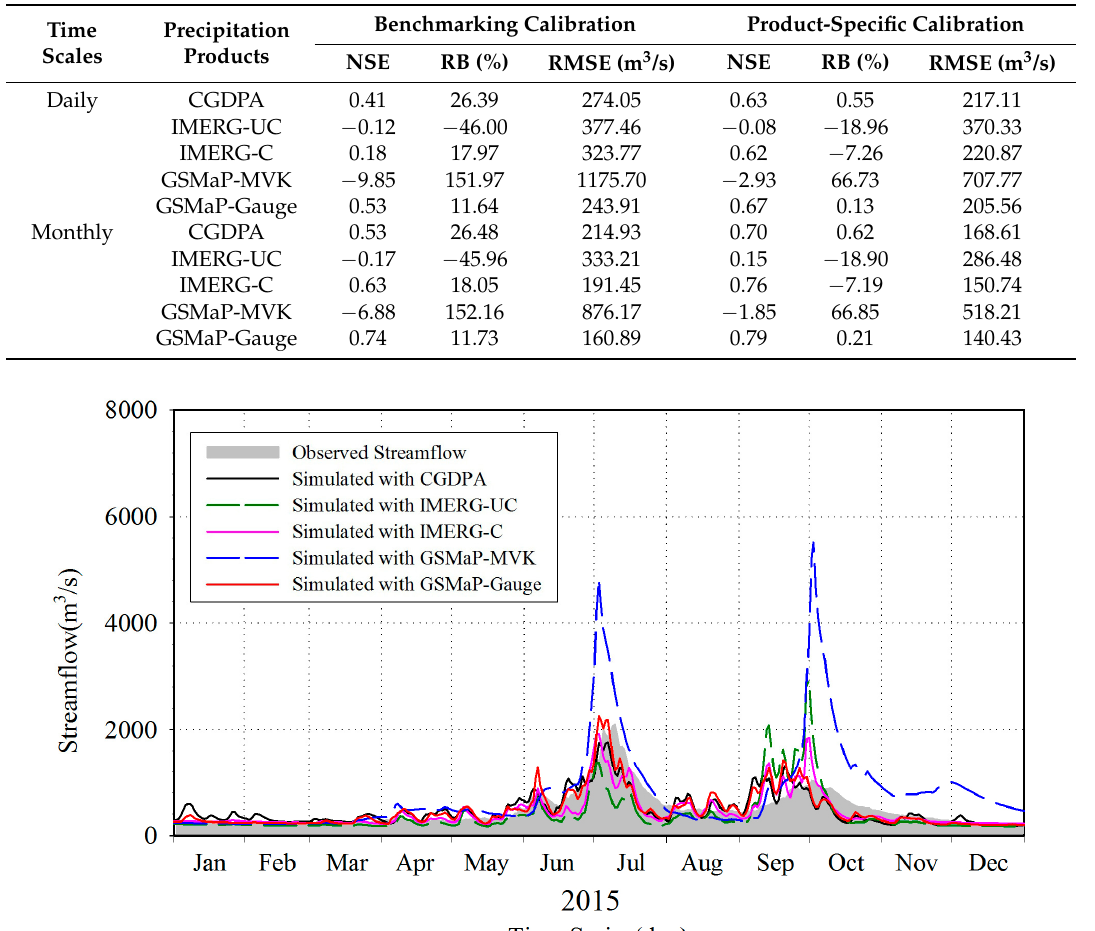
Table 6. Comparison of daily and monthly observed and simulated streamflow when the Variable Infiltration Capacity (VIC) model was forced by the gauge- and satellite-based precipitation datasets in 2015.